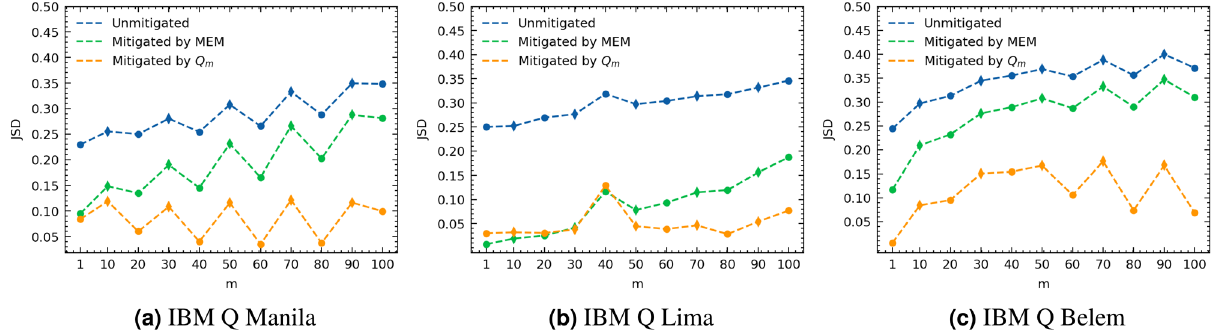
Figure 3. Average JSD between the ideal output | in � and each of the unmitigated output ˆ q ( m , s , | in � ) , mitigated output by the MEM protocol, and mitigated output by our proposed noise model for each depth m on IBM Q 5-qubit quantum